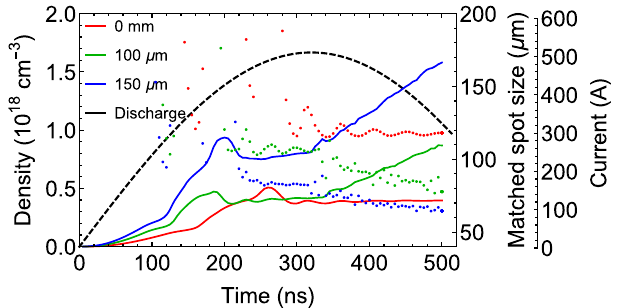
FIG. 3. Temporal evolution of the current (black, dashed line), as well as on axis density (colored lines) and matched spot size (colored points) for solid N 2 O layers of thickness 0 (red), 100 (green), and 150 μ